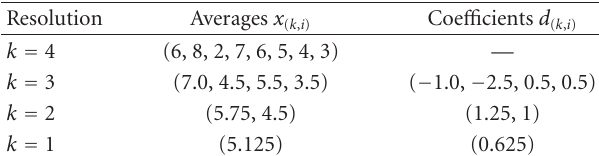
Table 1: Example of Haar wavelet transform.